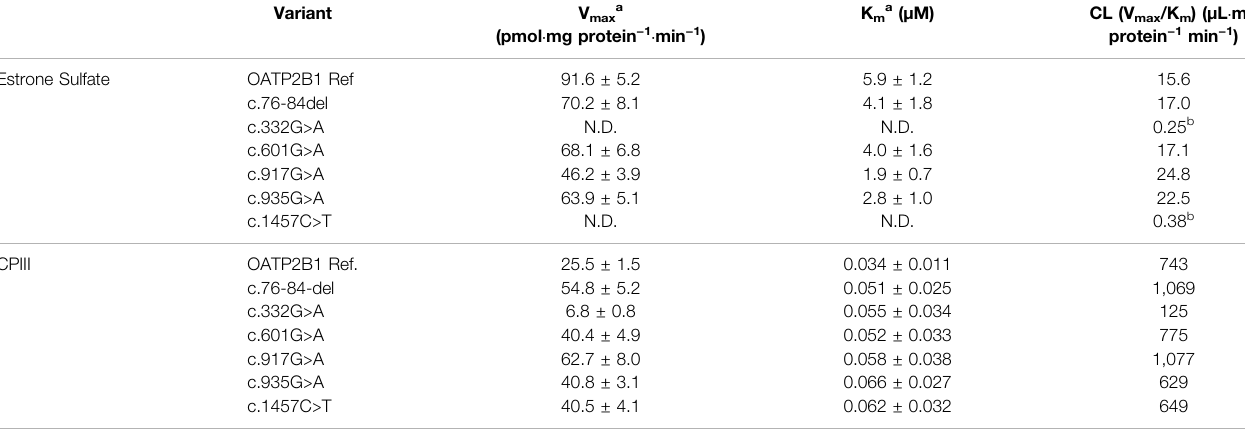
TABLE 2 | Estrone Sulfate and CPIII transport kinetics by OATP2B1 and its genetic variants.